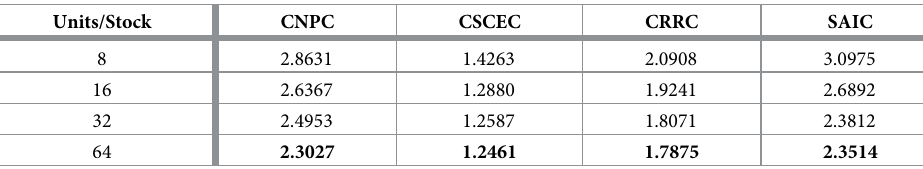
Table 7. MAPE value of common stock in different number of units (%).